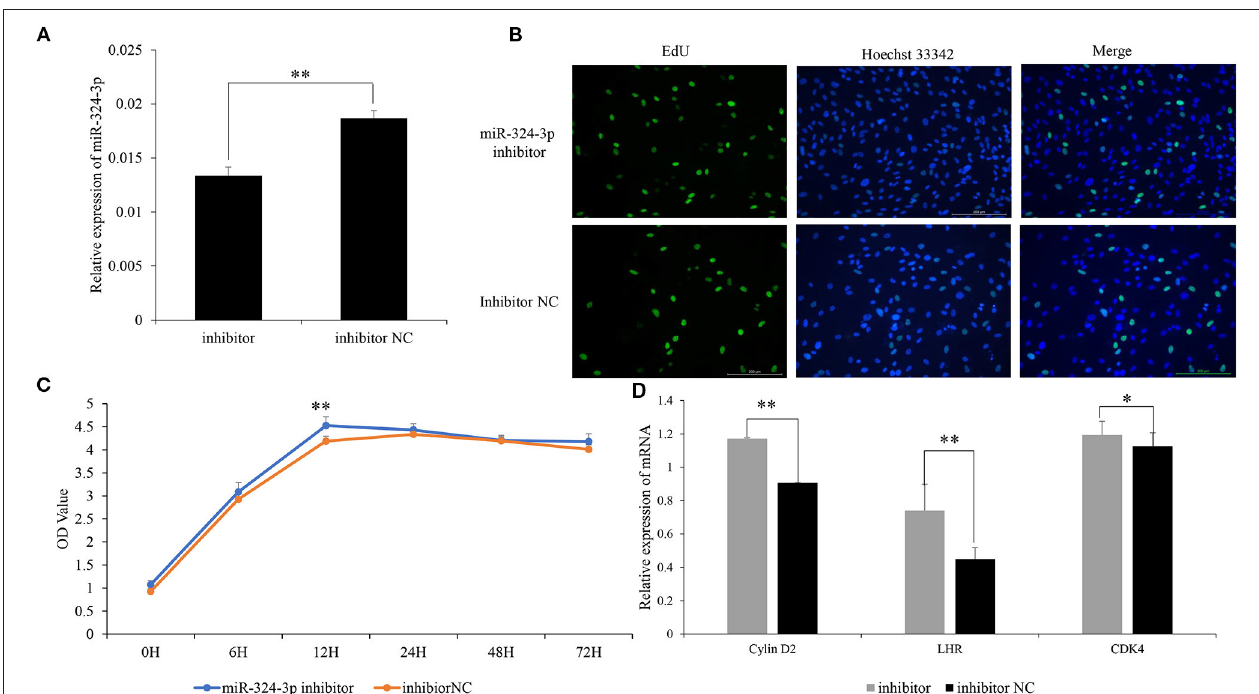
FIGURE 3 | Inhibited chi-miR-324-3p expression in goat GCs. (A) Relative expression of miR-324-3p. (B) The result of EdU assay. (C) CCK-8 assay of goat GCs with miR-324-3p mimic and mimic NC transfection at 0–72h. (D) Relative expressions of LHR , CDK4 , and Cylin D2 in transfected chi-miR-324-3p mimic and mimic NC at 48h. * p < 0.05; ** p < 0.01. CCK-8, Cell Counting Kit-8; GC, granulosa cell.